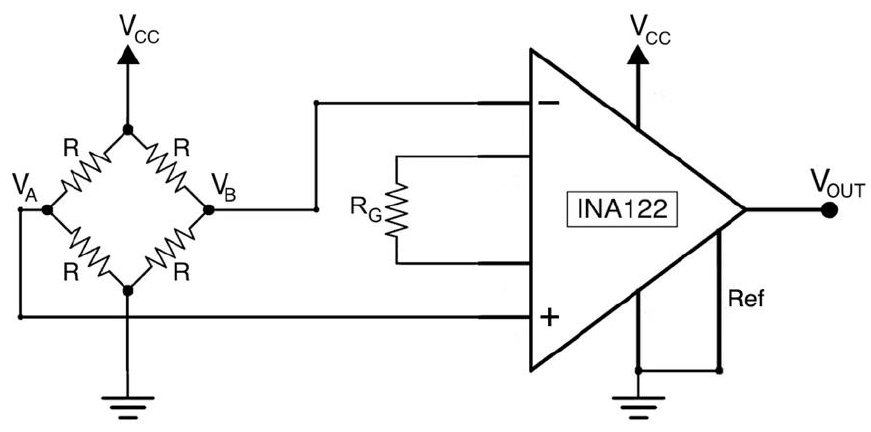
Figure 2. Load cell conditioning circuit based on instrumentation amplifier (INA122).